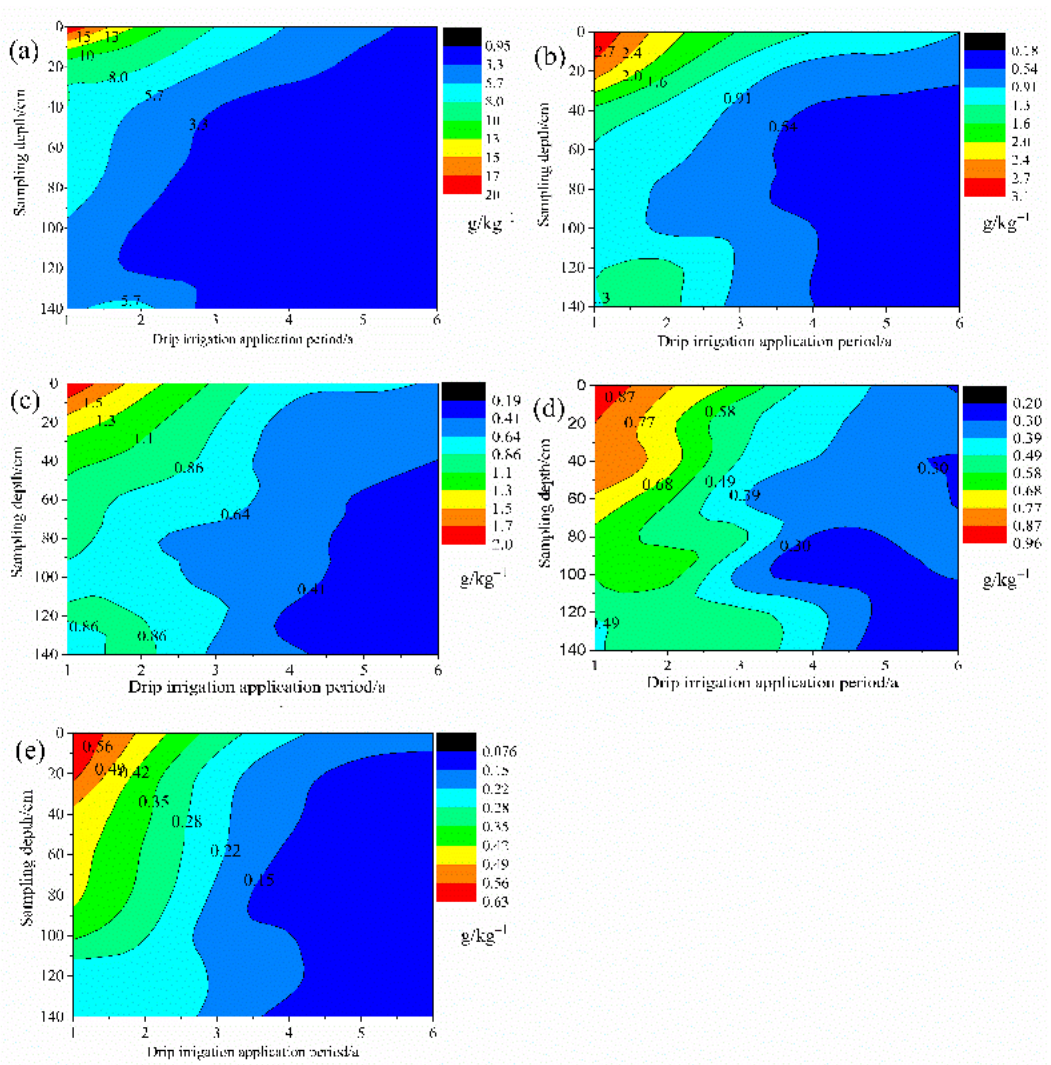
Figure 5. A contour plot showing the changes in ions content (g kg − 1 ) over the six study periods from the surface to depth of 140 cm. Figure ( a – e ) represent the distribution of ( a ) Na + , ( b ) Ca 2+ , ( c ) Mg 2+ , ( d ) SO 42 − and ( e ) Cl − , respectively. Table 3. SAR and CSER values in different subdivisions of the studied profile during periods from 1 a to 6